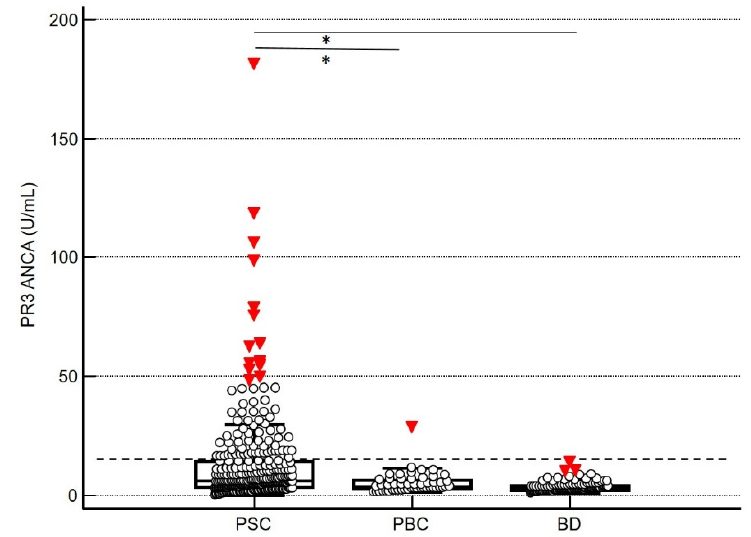
Figure 1. PR3-ANCA levels by third-generation ELISA in sera of 309 patients with primary sclerosing cholangitis (PSC), 51 patients with primary biliary cholangitis (PBC) and 120 blood donors. Data are displayed as units per milliliter in box-and-whisker plots with far out values defined as values that are smaller than the lower quartile minus three times the interquartile range or larger than the upper quartile plus three times the interquartile range, displayed as solid red triangles. The recommended cut-off of 15 U/mL is indicated as a horizontal dashed black line. * p < 0.05, Kruskal–Wallis test with Conover’s post hoc analysis.